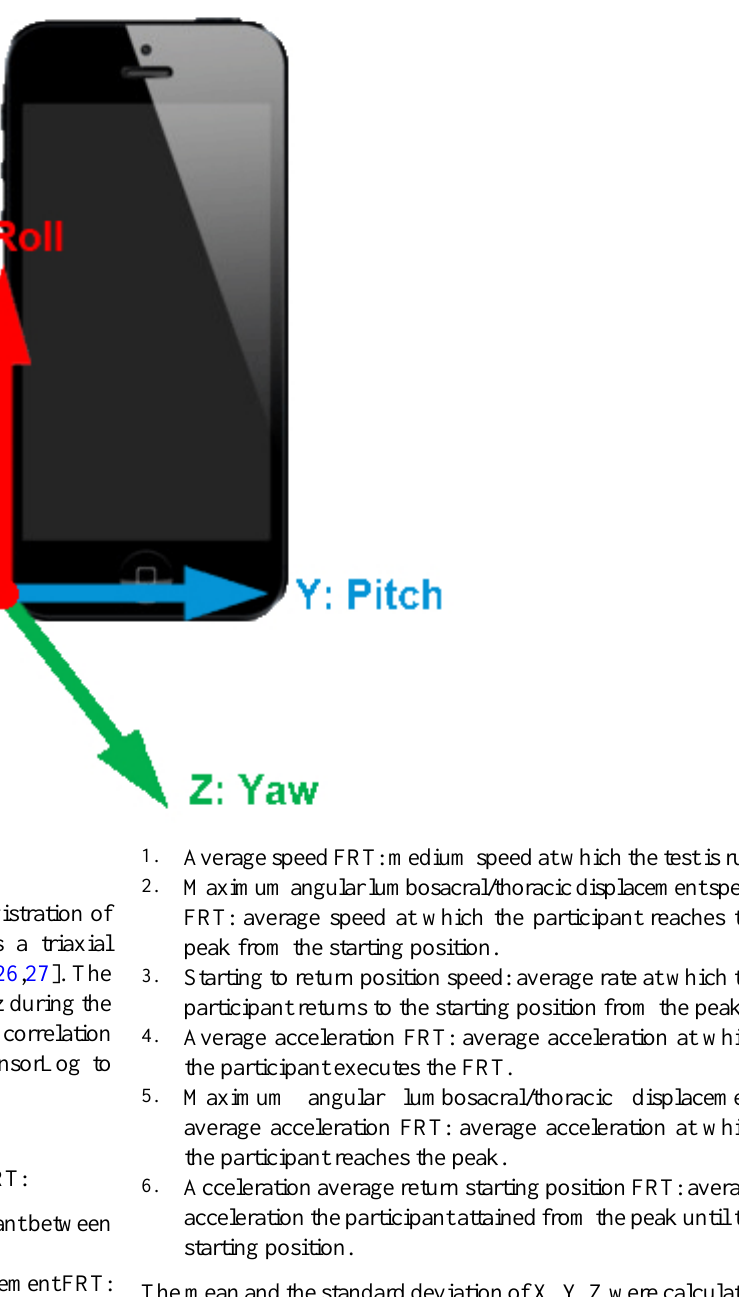
Figure 1. Origin of the coordinates (X, Y, Z) in the